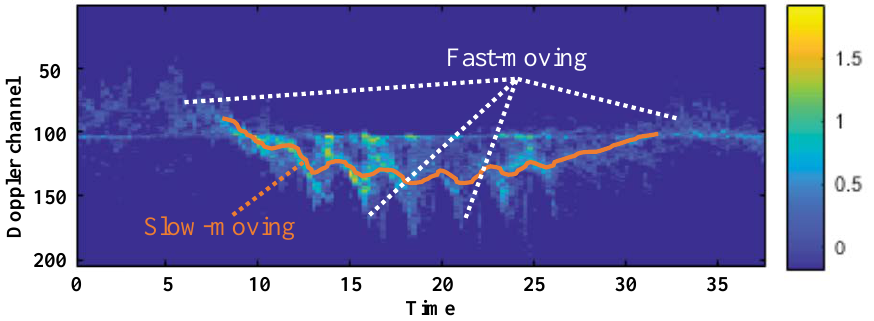
Figure 1. Micro-Doppler signature of human walking. When a person walks, the arms and legs generate fast-moving signatures represented by a white line, and the torso generates slow-moving signatures indicated by an orange